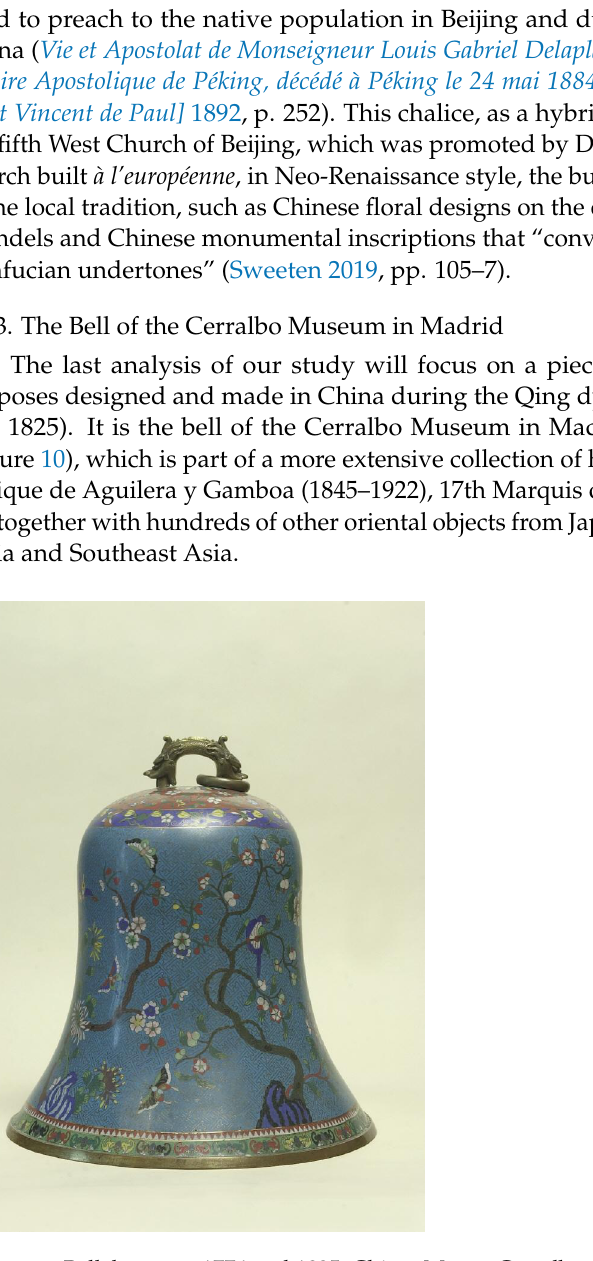
Figure 10. Bell, between 1776 and 1825, China. Museo Cerralbo, Madrid. Photo: Museo Cerralbo. Made of copper and cloisonné , with dimensions of 36.5 × 35.7 cm, in its upper part it presents a rounded shape in which a golden two-headed dragon hanger is inserted, the fifth symbol of the Chinese zodiac and related to the emperor. This solar symbol, which expresses Yang energy, that is, virile power and strength, applied to a Christian element could refer to Christ as the center from which power and glory emanate. The skirt with a turquoise blue background, partitioned with a geometric grid, presents plum (winter), peony (spring) and chrysanthemum (autumn) flowers, with birds on the branches and butterflies in flight ( 蝴蝶 hú dié ). This type of motif dates back to the Song dynasty (960–1279), to the paintings of traditional naturalistic landscapes of mountains, flowers, fruits and birds. Closely linked to Taoism, these floral representations pursued the inte- gration of nature and man, and the experience of their vital rhythms. The references to the seasons in the decoration of the bell complete the iconographic program of the Chaflán Hall of the Cerralbo Museum, which was once a private home. This room, in- tended for gatherings and rest after dancing, also presents a pictorial mural decoration based on the cycle of the seasons of the year, with elements that refer to the process of cultivating the land. The bell also has a border with bats on a green background on the lower edge, on which there is another, narrower, of red and white triangles, motifs in- troduced at the end of the Qing dynasty as a symbol of good omen for the owner of the object. In Chinese, the word bat and happiness are homophones ( fu ), so this type of rep- resentation would be very common during this time, which coincides with the reign of Emperor Qianlong (1735–1796). In the upper area, a radial pattern of chrysanthemum surrounded by other flowers, stems and floral border with butterflies frames the ensem- ble, also similar to another enamel bell with bronze dragon fittings preserved in the Museo Nacional de Artes Decorativas in Madrid (Accession number DE10240). Regarding the original function of the Cerralbo bell, it can be said that it would be a decorative or symbolic object, since the enamel would come off if the bell rang regularly. It could be an ornamental export work intended for the West or a symbolic bell for the Chinese Christian community, just as Buddhist cloisonné bells were made not to be tolled but to be displayed among the objects with religious or moral connotations in the dens of monks and scholars.